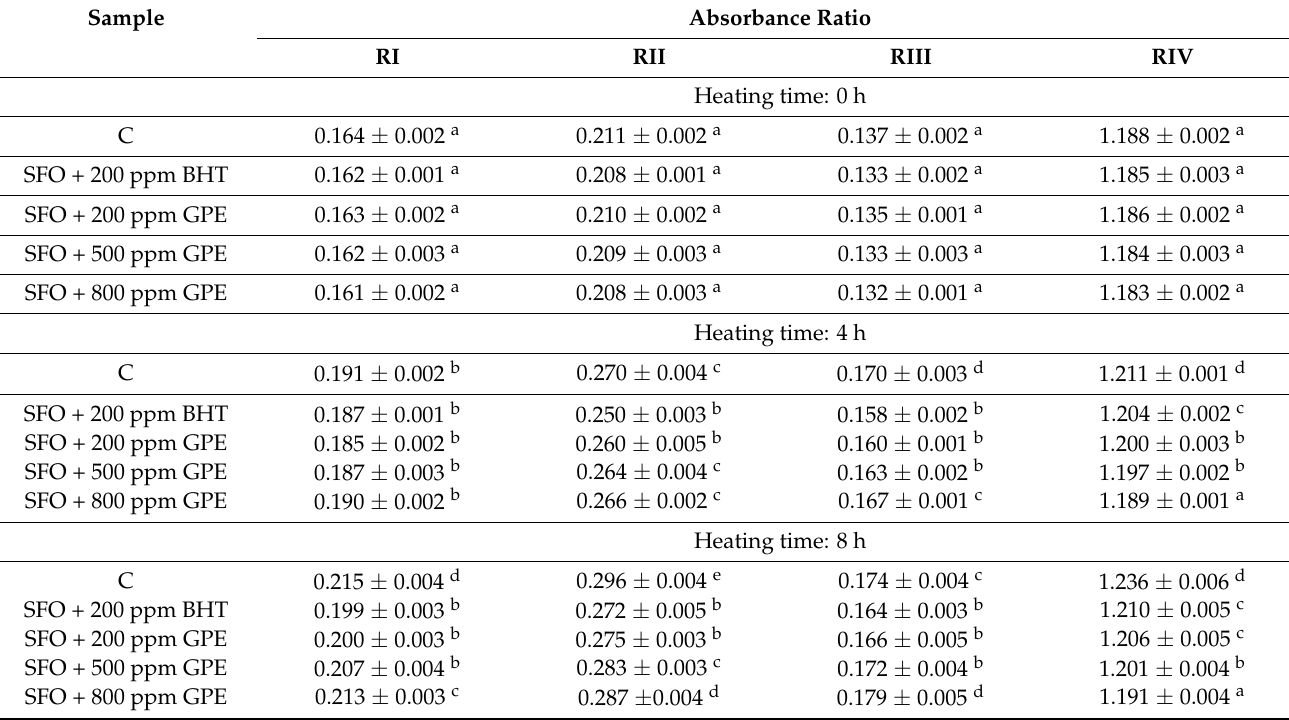
Table 6. Changes in the absorbance ratios of some specific bands of the infrared spectra of heat-treated oil samples for 4 h and 8 h compared to untreated